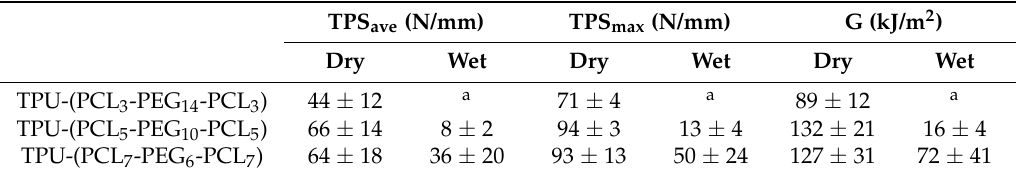
Table 5. Tear propagation resistance of the different TPU-(PCL- b -PEG- b -PCL) polymers in the dry and in the wet state ( n = 5, average ± SD).